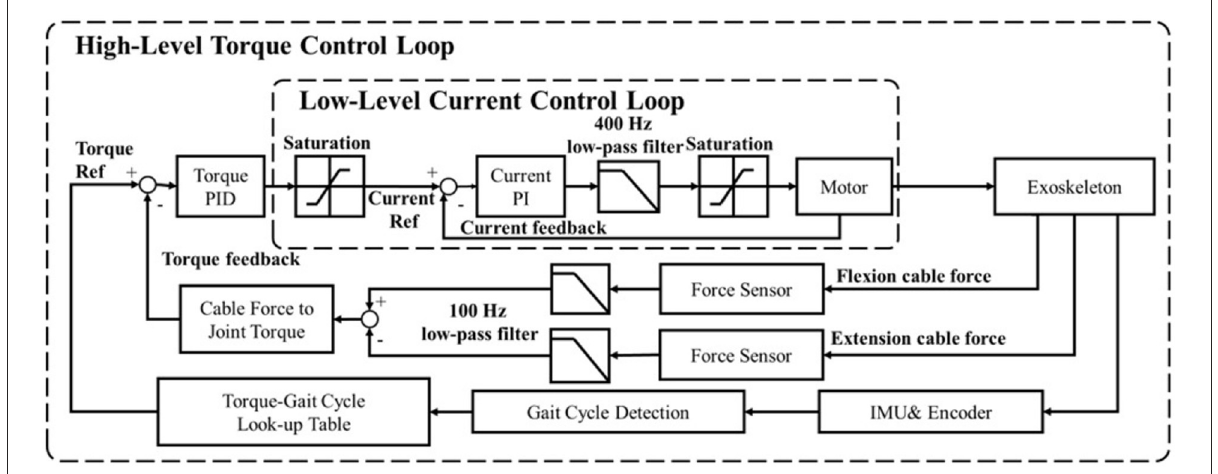
FIGURE7 Block diagram of the control architecture. The motor low-level controller performs current PI control by using actuator integrated sensors for feedback, while the high-level torque PID control uses two force sensors to obtain joint torque